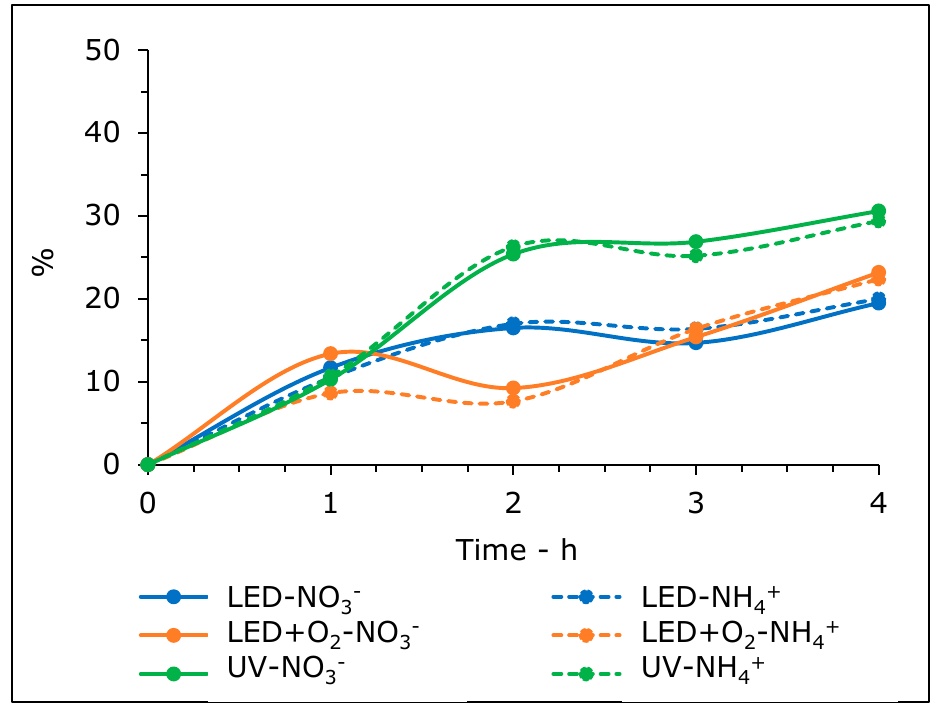
Figure 10. Photo-reduction of NO 3 − under LED or UV lamp using 0.05 g of 0.1% Ag/FSP photocata- lyst, NaNO 3 (1.7 mM), NH 4 Cl (2.8 mM), pH 5, rt and 1000 mL of solution (Reactor 2). LED test was repeated with air bubbling (air flow 12 mL/min).